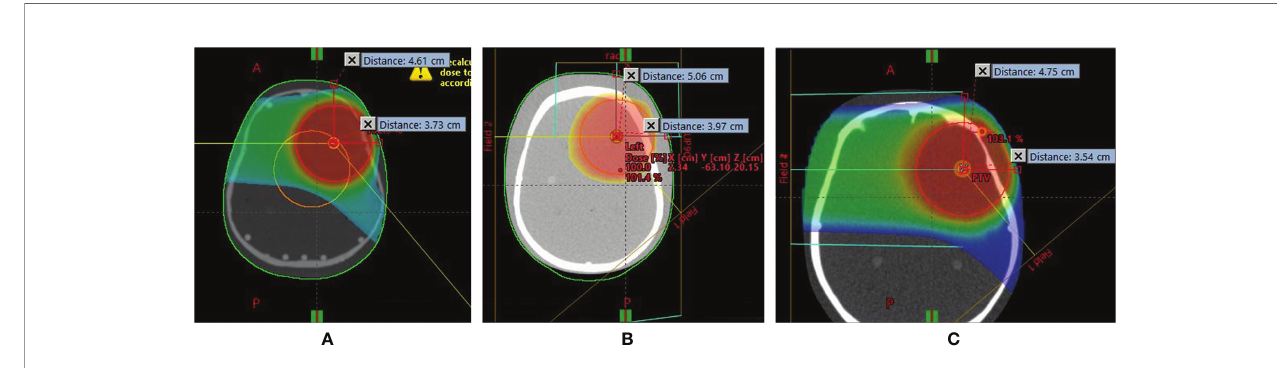
FIGURE 1 | Position of intracranial tumor inside the left hemisphere of (A) 1-year-old, (B) 5-year-old, and (C) 10-year-old pediatric anthropomorphic phantoms.